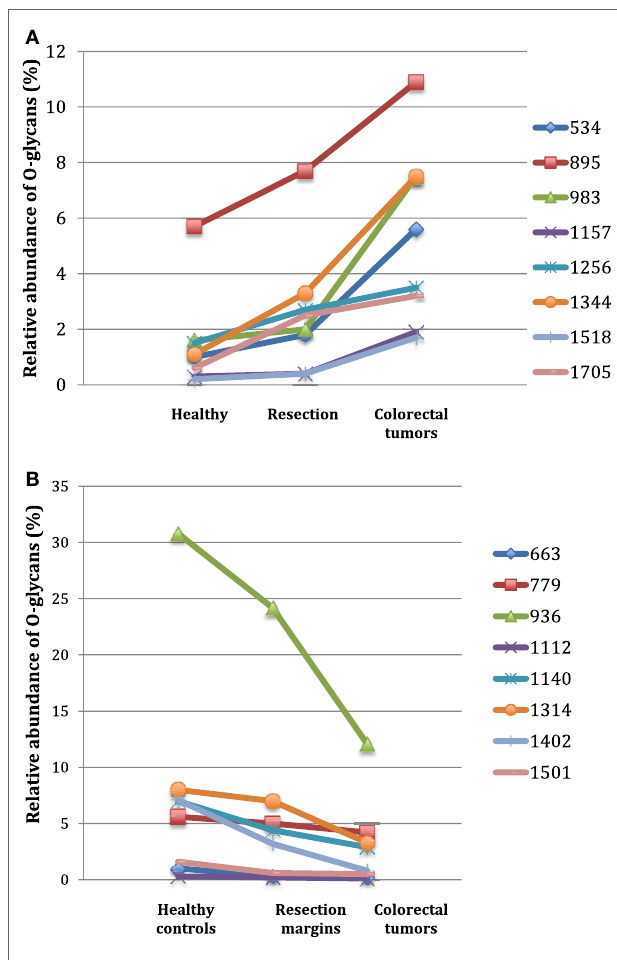
FigUre 2 | gradients in the level of expression of mucin O-glycans from healthy controls colonic tissues ( n = 5) to resection margins ( n = 10) and paired tumors of patients ( n = 10) with colorectal cancers . The mean is represented for all measurements. (a) CRC-specific increase in the level of expression of O-glycans corresponding to ions at m/z 534, 895, 983, 1,157, 1,256, 1,344, 1,518, and 1,705. (B) CRC-specific decrease in the level of expression of O-glycans corresponding to ions at m/z 663, 779, 936, 1,112, 1,140, 1,314, and